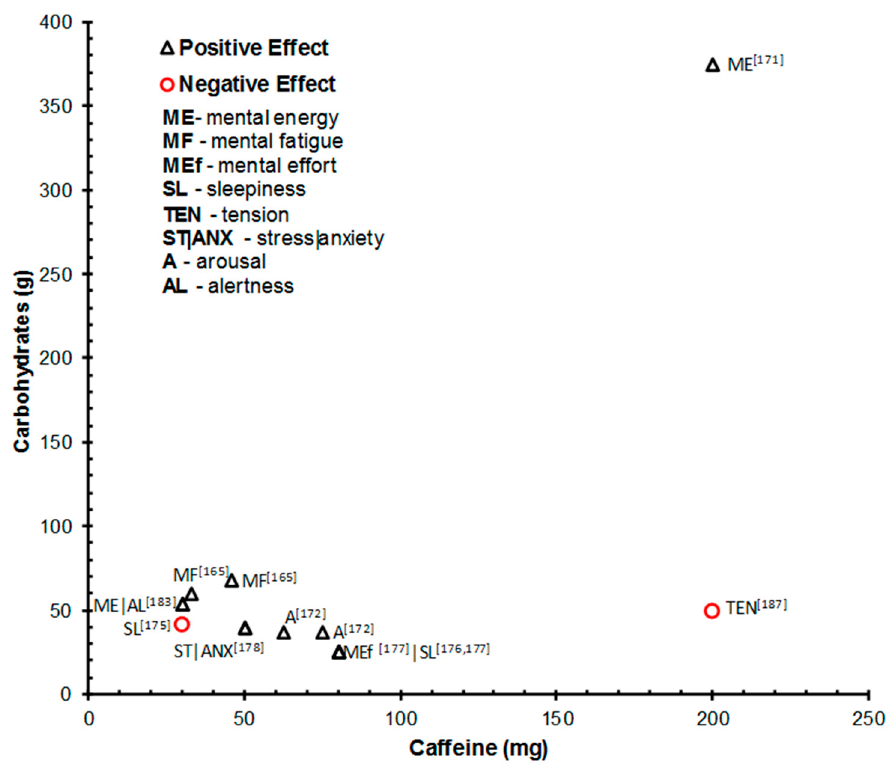
Figure 2. Scatterplot of subjective outcomes (enhanced or impaired) by caffeine and CHO drink content. Data are representative of all studies reviewed and include multiple outcomes reported by single studies. Howard and Marczinski [176] not shown due to caffeine/CHO being administered based on body weight. Ani ţ ei et al. [174] not shown as do not state CHO dose.